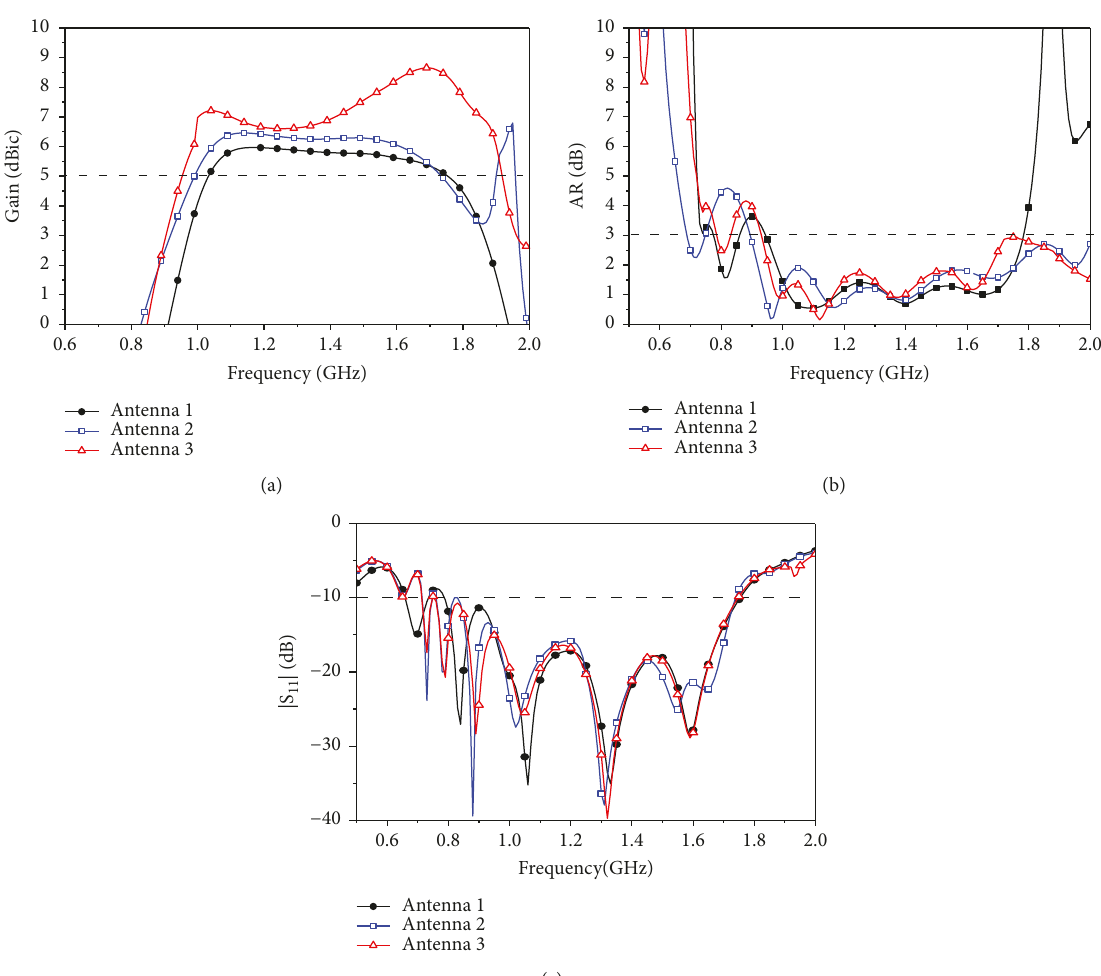
Figure 4: Comparison of ARs, gains at broadside direction, and S